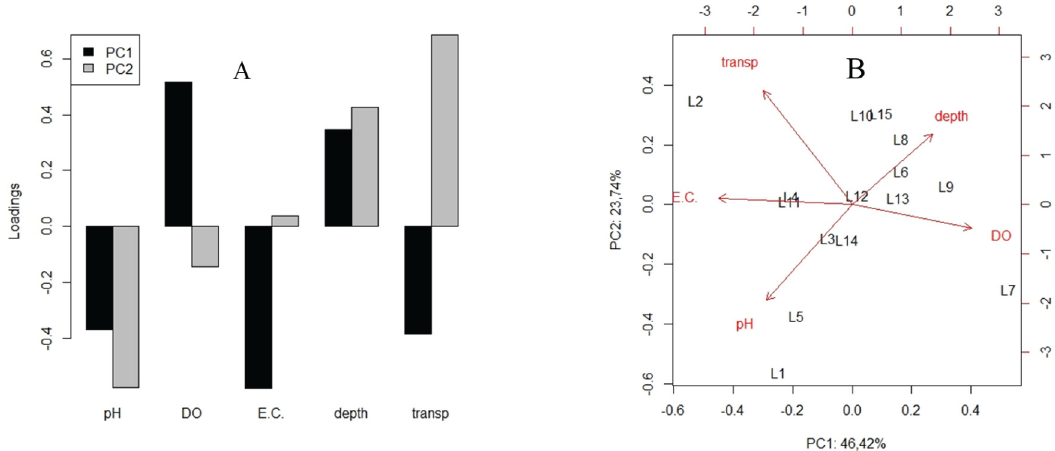
Figure 3. Result of the Principal Components Analysis (PCA) for the physiochemical variables showing the variable, its loadings (A) and the percentage of variance explained through the two first components (B) in the 15 marginal lakes along to the Paraguay River, MT sampled in September of 2005.